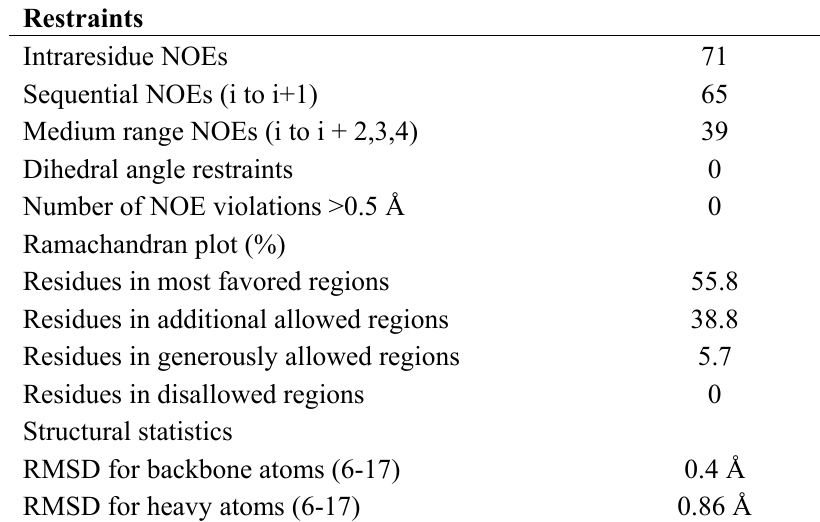
Table 1. Experimental distance and statistics for the 20 structures determined in SDS micelles.